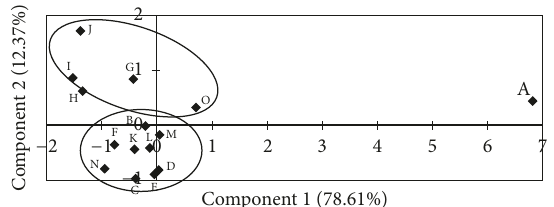
Figure 3: Analysis of major components of heavy metal content in the roasted ground coffee samples. Distinguished groups across Euclidean distance.